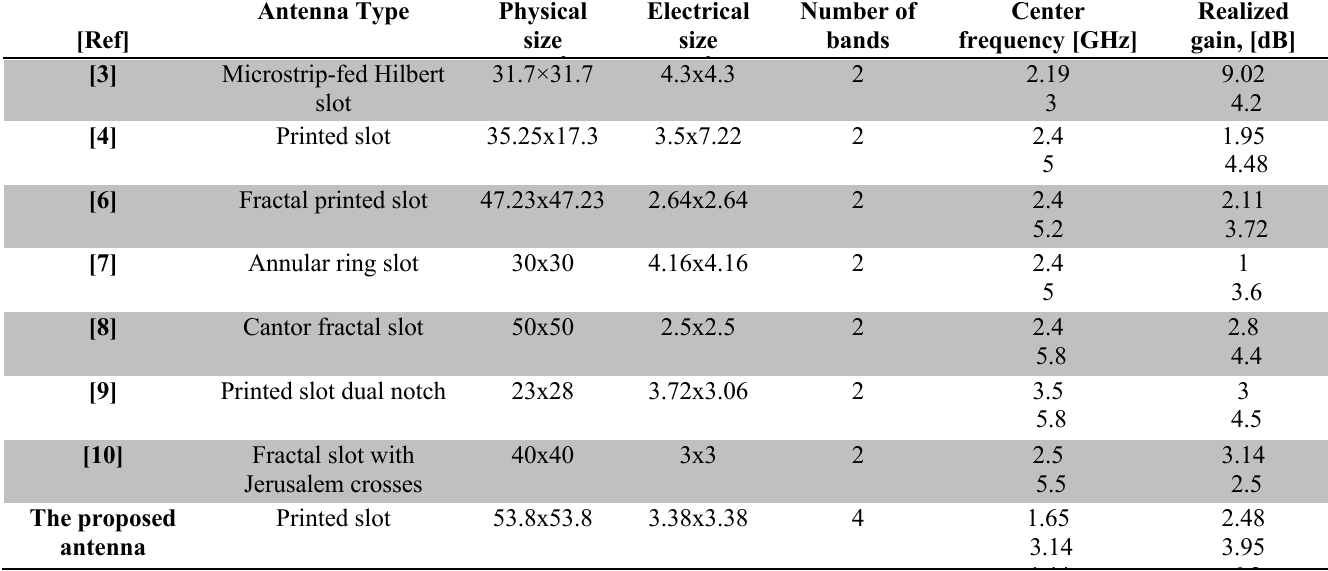
Table 3: Comparison with previous